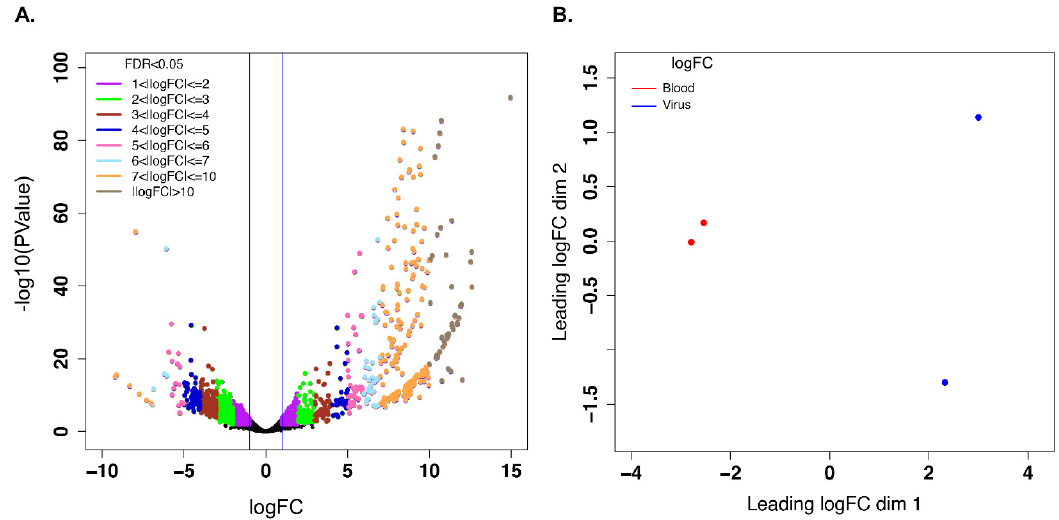
Figure 1. Visualization of differential gene expression analysis using edgeR. ( A ) Represents the volcano graph derived by plotting the log of the FDR-adjusted p value as a function of Log 2 of the fold change (“logFC”) for each transcript in EHDV-fed midges vs. controls. ( B ) Represents the multidimensional scaling plot of the relationship matrix which is derived from Log 2 fold change of the differentially-expressed unigenes across the sample groups showing separation of controls vs. EHDV-fed groups. EHDV-fed